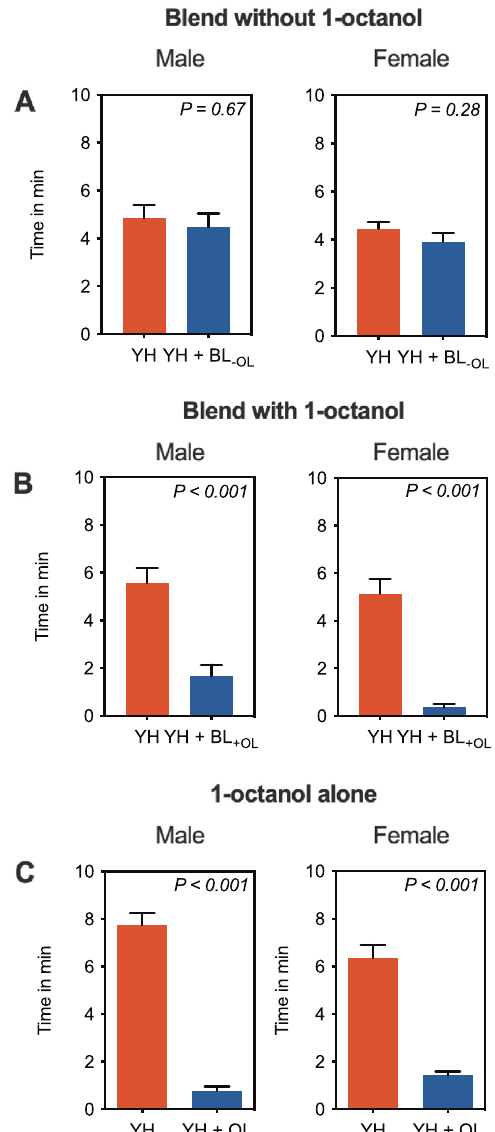
Figure 3. Behavioural response of male and female B. tryoni to synthetic blends with (BL +OL ) or without (BL −OL ) 1-octanol, and 1-octanol alone (OL). In behavioral assays using synthetic blend of headspace voltiles without 1- octanol, male and female flies spent similar time in control (YH; Yeast hydrolysate) and treatment (YH + BL −OL ) arms. However, in behavioural assays using a synthetic blend of headspace volatiles with 1-octanol or 1-octanol alone, male and female flies spent significantly ( P < 0.001) more time in control (YH) than treatment (YH + BL +OL ) arms. Error bar represent s.e.m. Significant difference was analysed by paired t -test (see Results